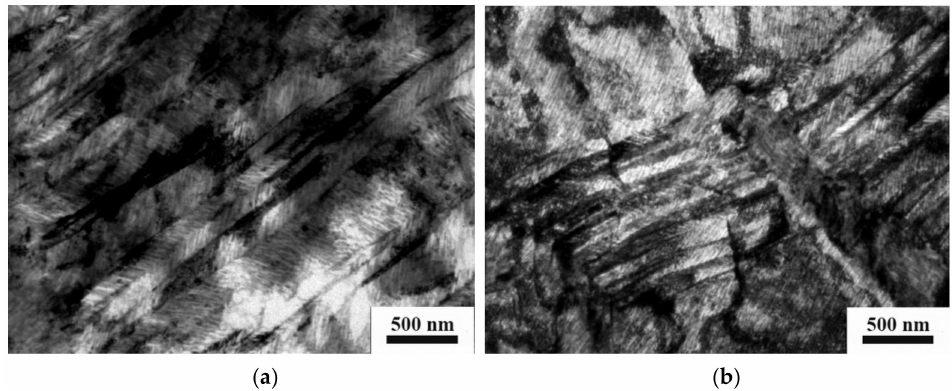
Figure 3. TEM observations of the fine microstructure of the TWIP steel subjected to 4 ECAP passes. Areas with refined extended deformation bands inhabited with nanotwins ( a ) and fragmentation of deformation bands ( b ) are shown.